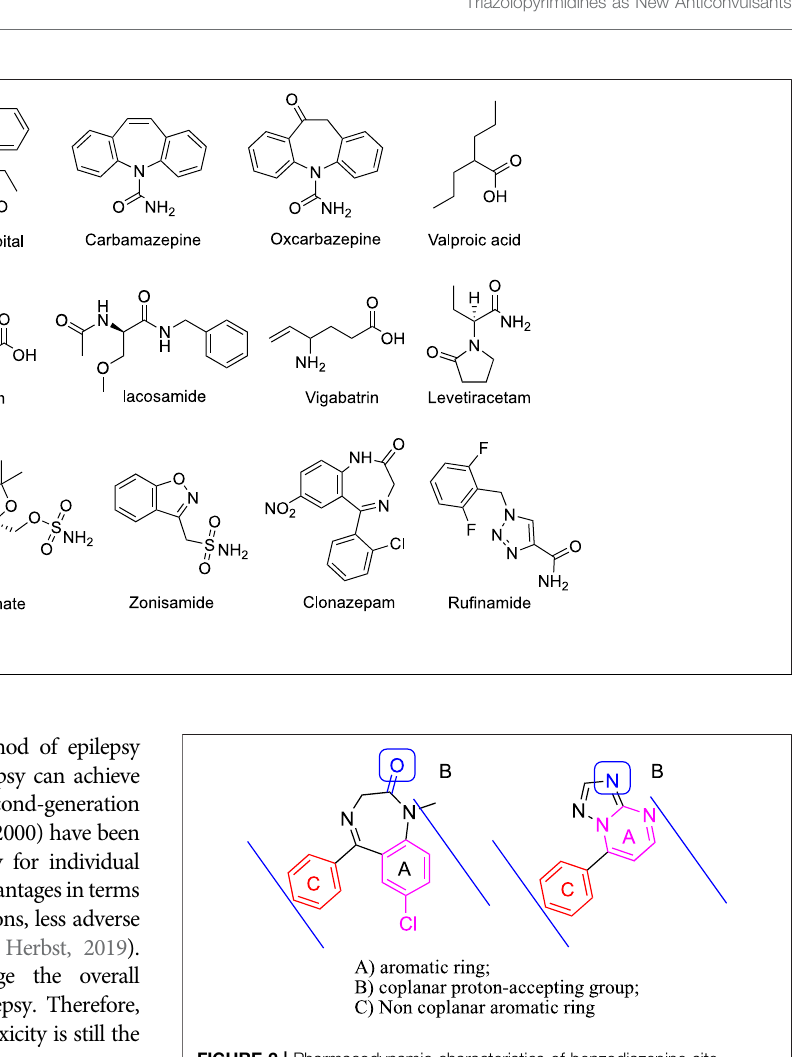
FIGURE 2 | Pharmacodynamic characteristics of benzodiazepine site agonists (diazepam as a representative) and compounds reported herein ( 3a as a